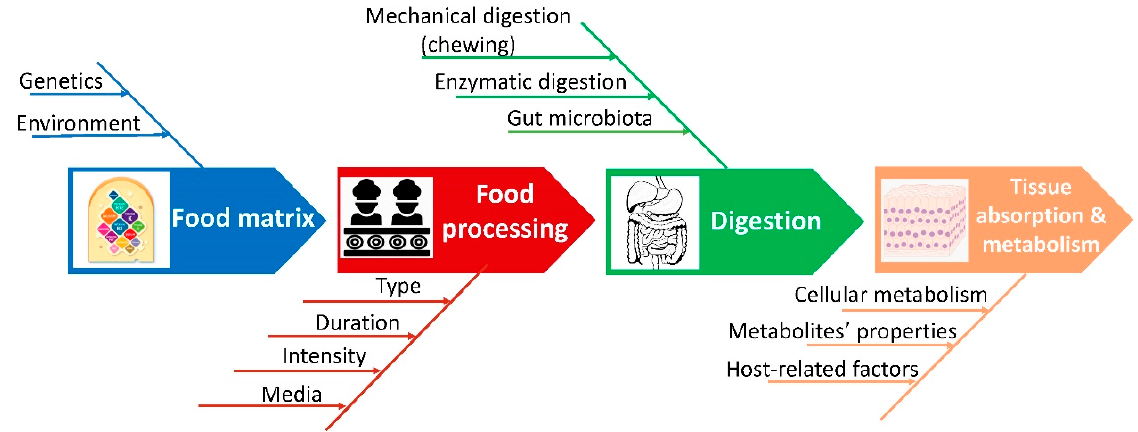
Figure 2. Main factors affecting dietary plant polyphenols content and bioavailability.